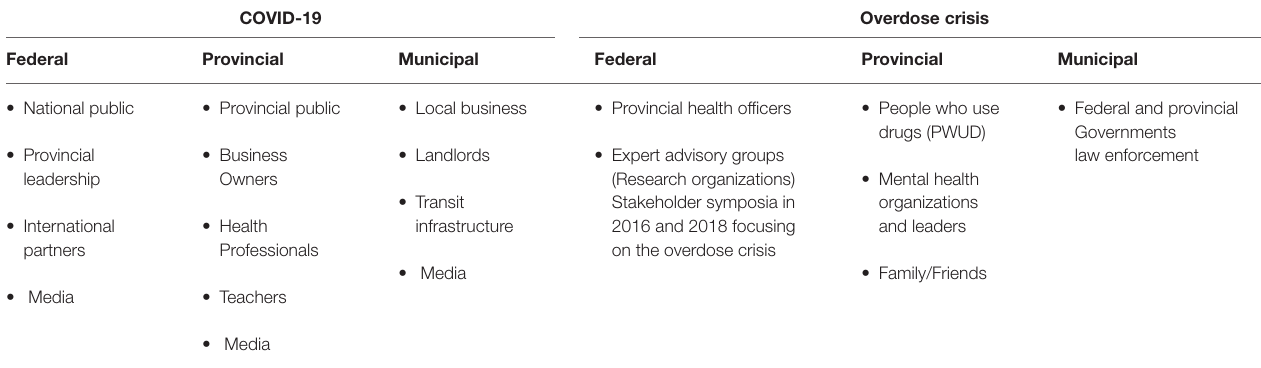
TABLE 1 | Who needs to receive the